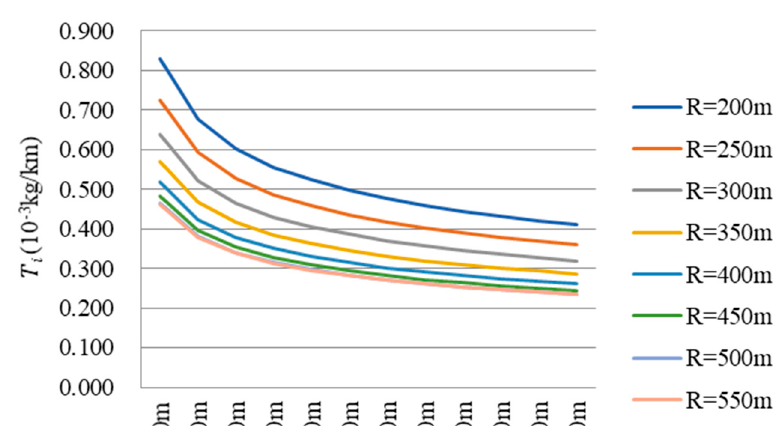
Table 9. Fitting parameters.